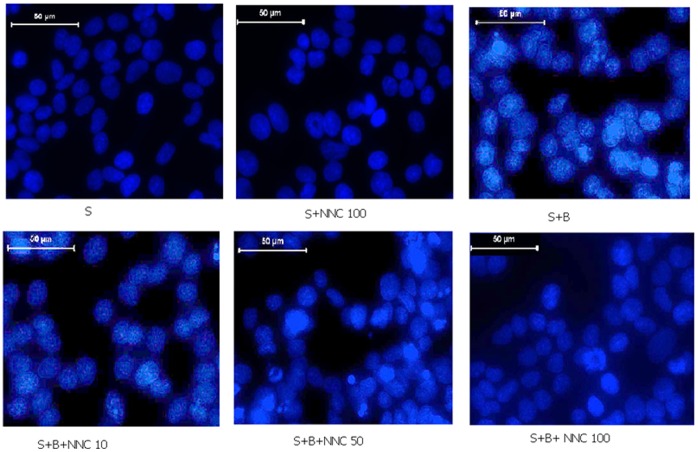
NNC 55-0396 dihydrochloride protects SH-SY5Y cells from bupivacaine-induced nuclear alterations during apoptosis.Cells were either treated with the indicated concentrations of NNC 55-0396 dihydrochloride or left untreated prior to 1 mM bupivaine treatment for 24 h. Nuclear morphology was evaluated by Hoechst 33258 staining (×200). Apoptotic cells were observed to have condensed or segmented nuclei accompanied by bright blue fluorescence.